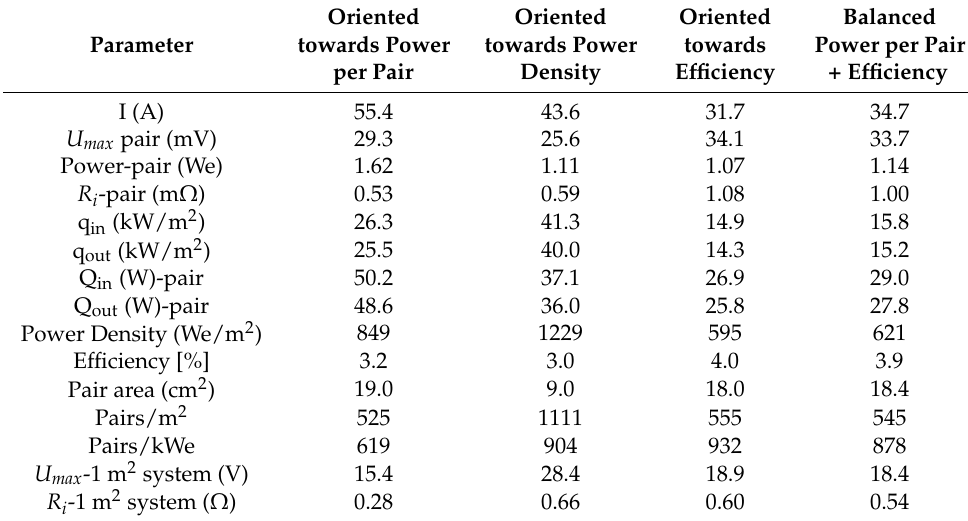
Table 2. Performance parameters of the optimized geometry. Oriented Parameter towards